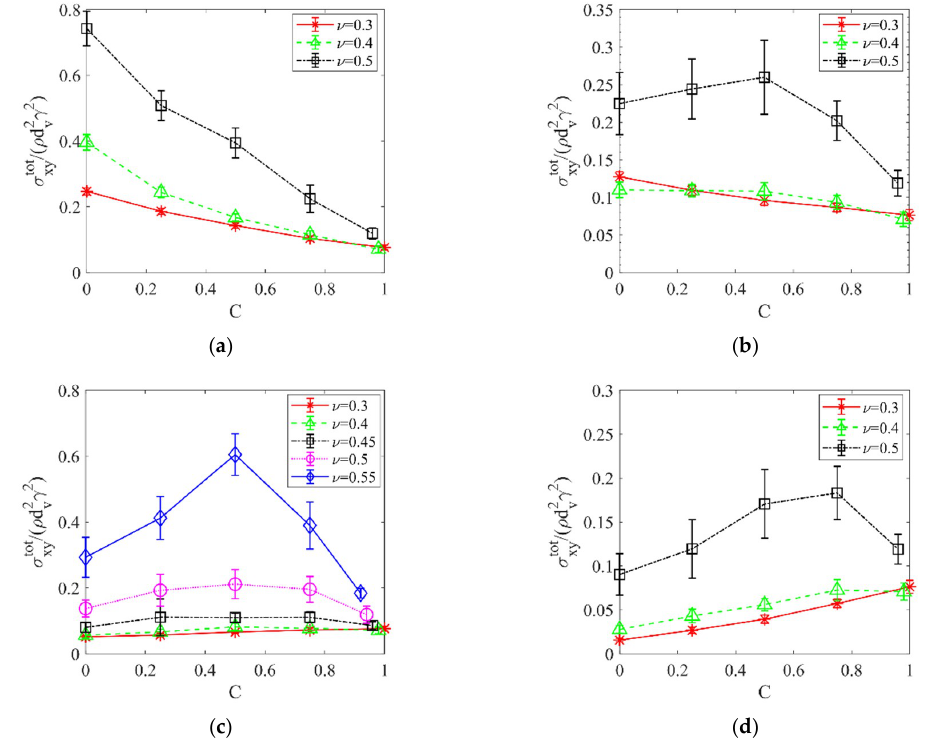
Figure 13. Variation of average normalized shear stress with rods fraction C for moderate and dense flows of the binary mixtures with ( a ) AR = 0.3 and AR = 6, ( b ) AR = 0.2 and AR = 6, ( c ) AR = 0.15 and AR = 6, and ( d ) AR = 0.1 and AR = 6. An error bar represents the standard deviation of the stresses from the average value at steady state.